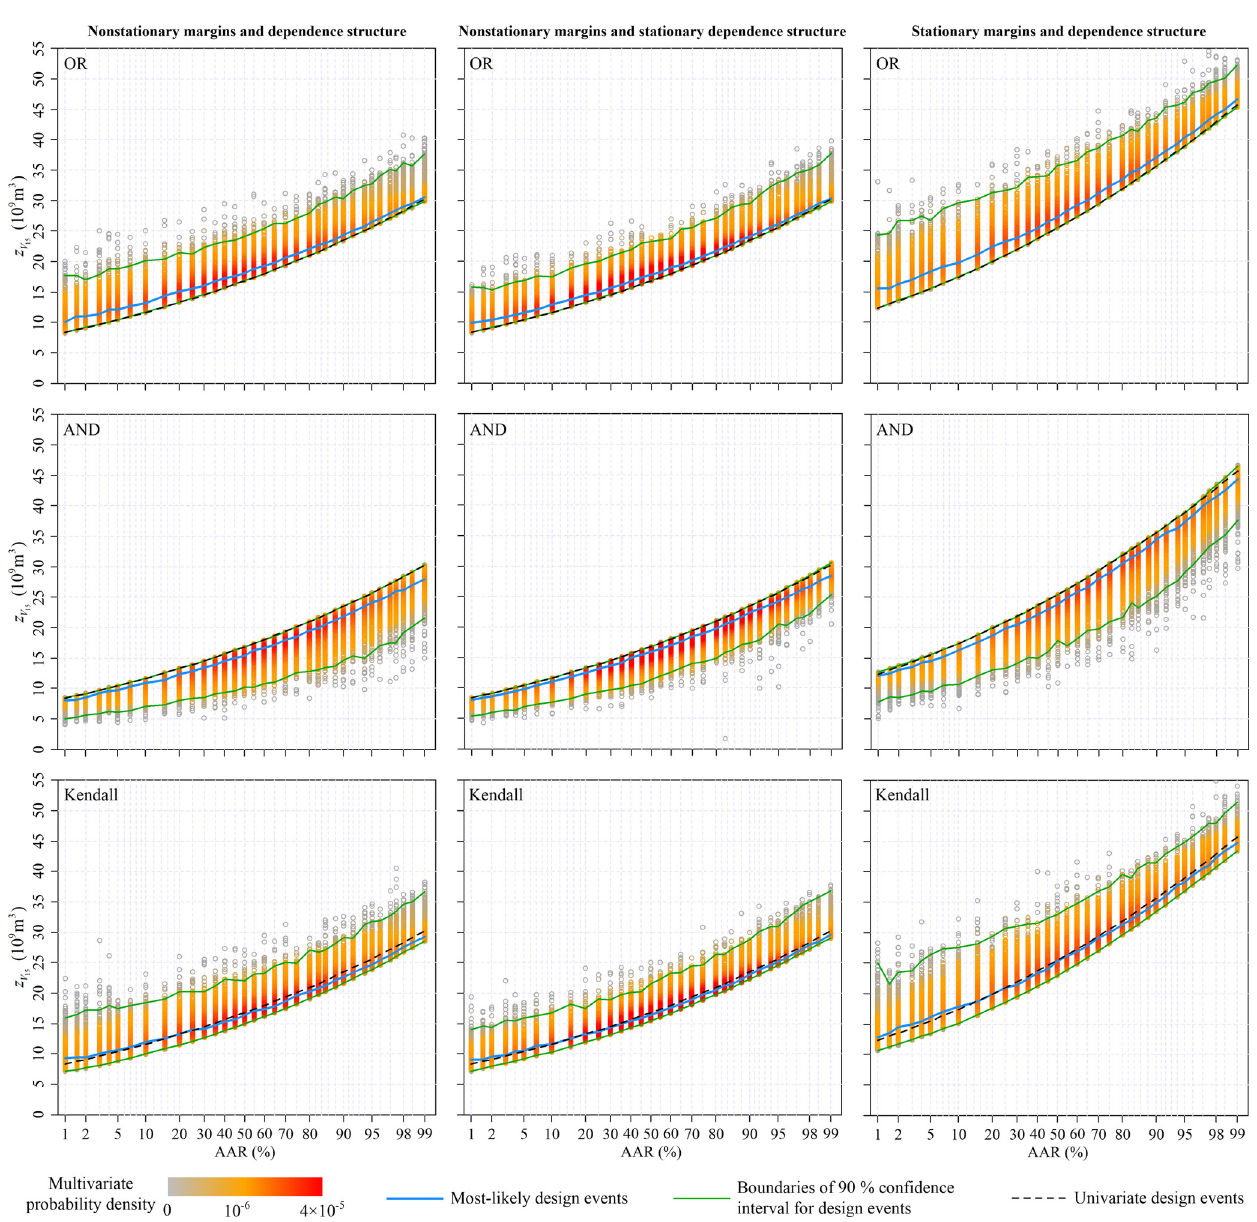
Figure 10. Design values of the 15-day flood volume for different average annual reliability (AAR) varying from 0.01 to 0.99 under three nonstationary